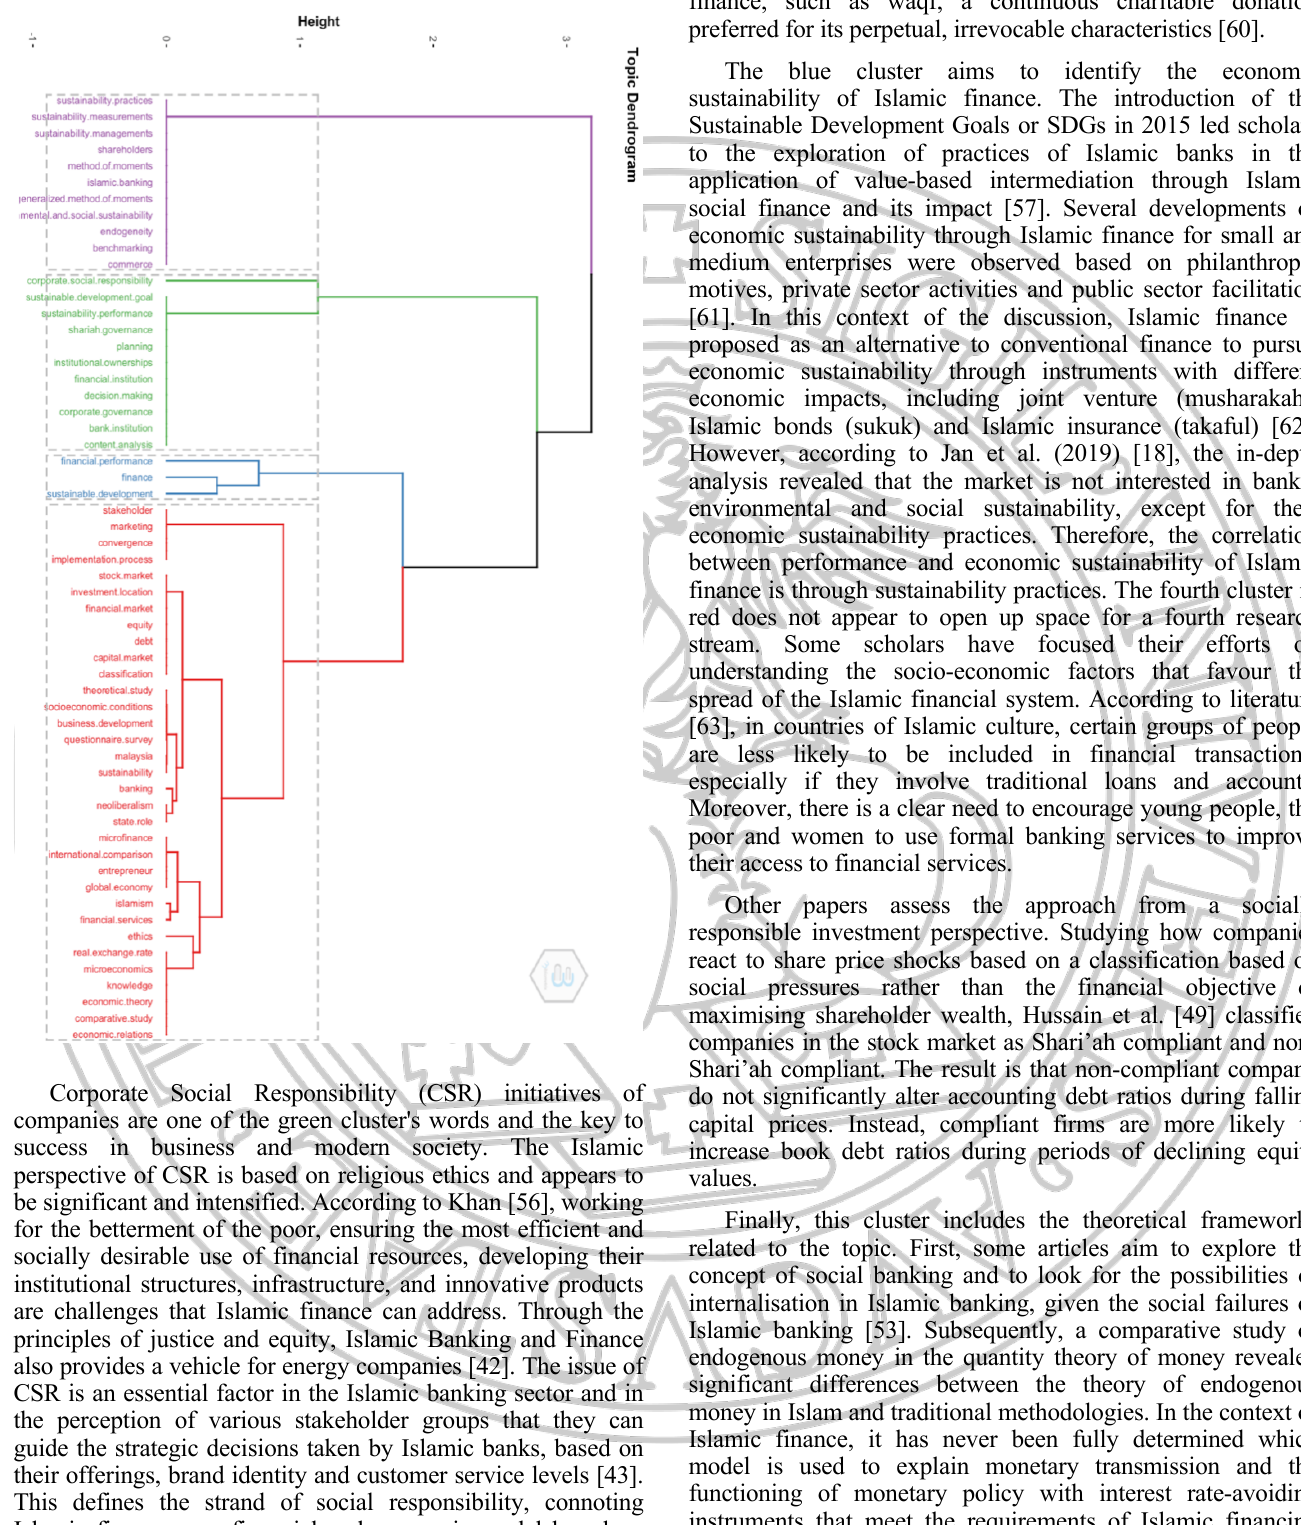
F IGURE 5. T OPIC